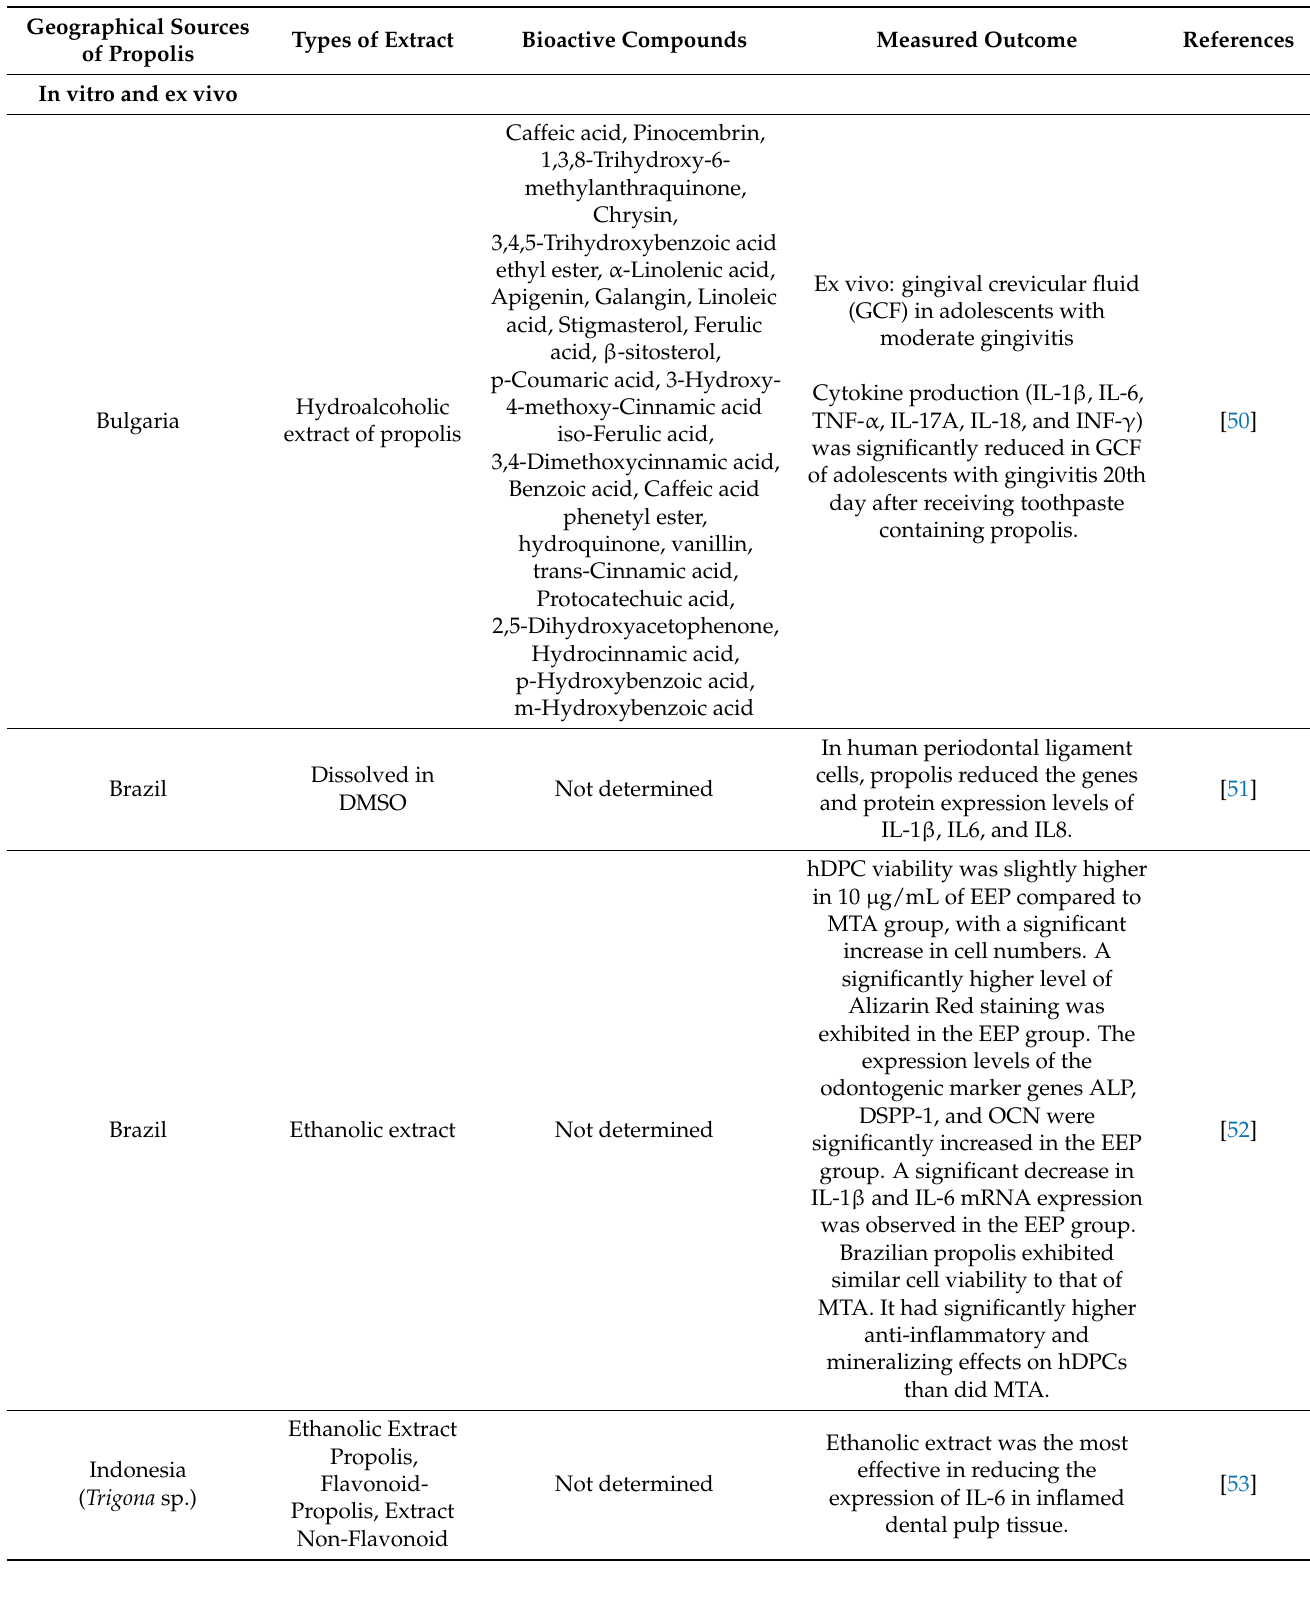
Table 3. Anti-inflammatory properties of propolis indental/ oral-related disorders and